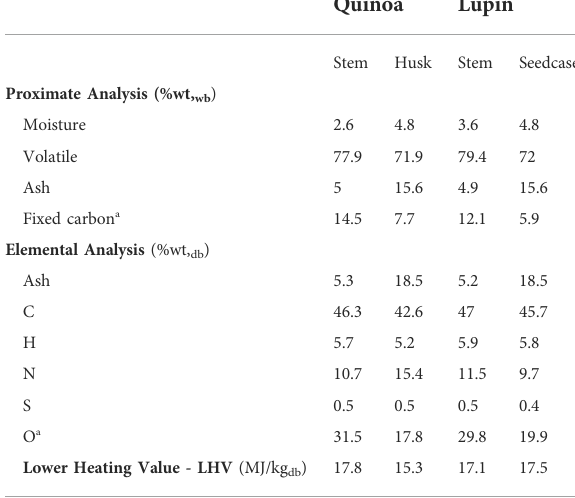
TABLE 1 Proximate and elemental composition of the agro-residues generatedafterthepost-harvestingprocessesofquinoaandlupin in the highlands of Ecuador (Heredia et al.,